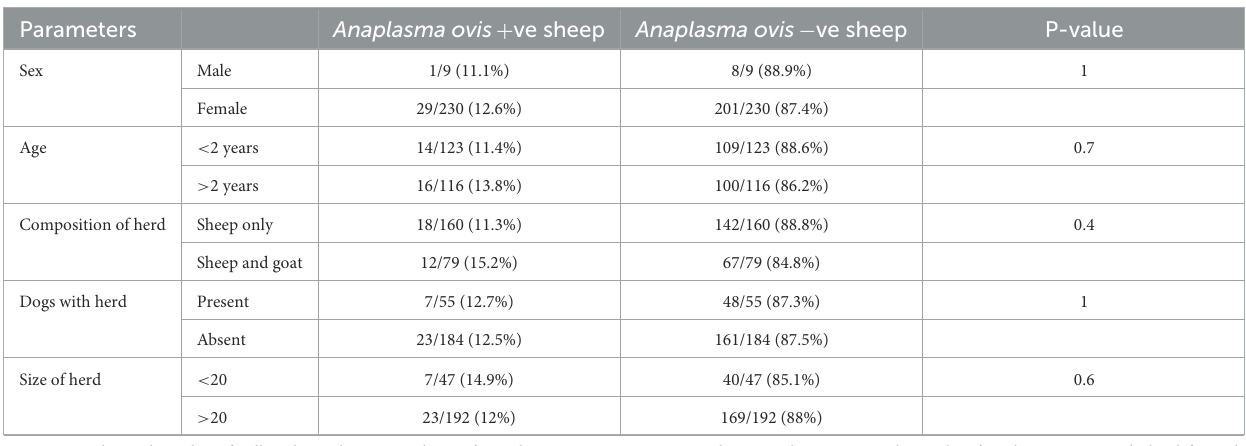
TABLE 2 Association of Anaplasma ovis prevalence with the studied epidemiological parameters describing sheep characters enrolled during the present study from District Dera Ghazi Khan.